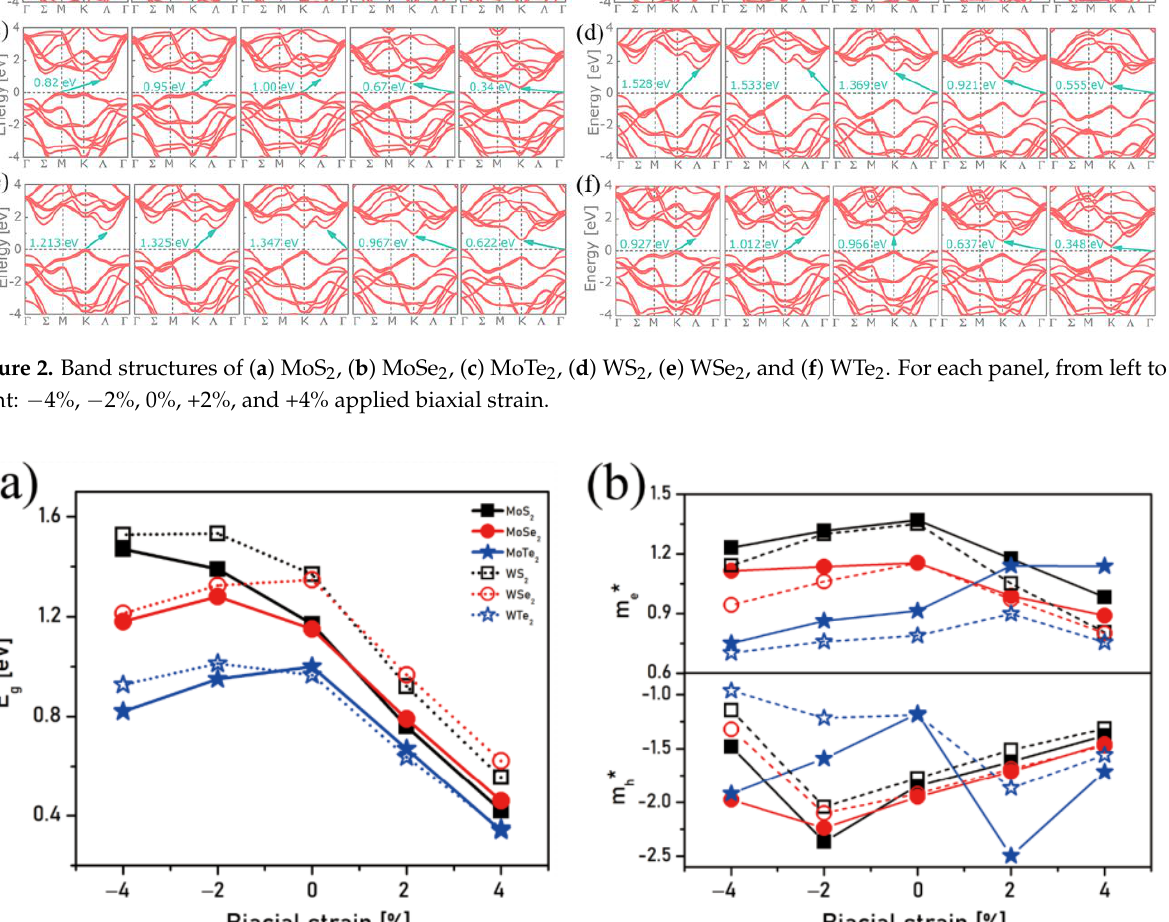
Figure 3. ( a ) Bandgap energies and ( b ) electron and hole effective masses (m e * and m h *, respectively) at the respective CBMs and VBMs with respect to applied strains from −4% to +4% for the MX 2 bilayer structures (M = Mo, W; X = S, Se, Te).